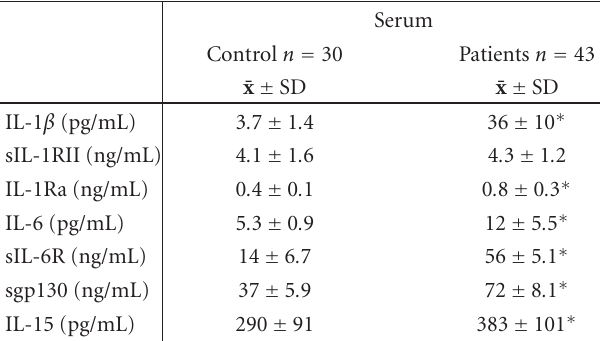
Table 3: The mean concentrations of IL-1 β , sIL-1RII, IL-1Ra, IL-6, sIL-6R α , and sgp130 in the serum of control and patients with Lyme disease. Serum Control n = 30 Patients n =